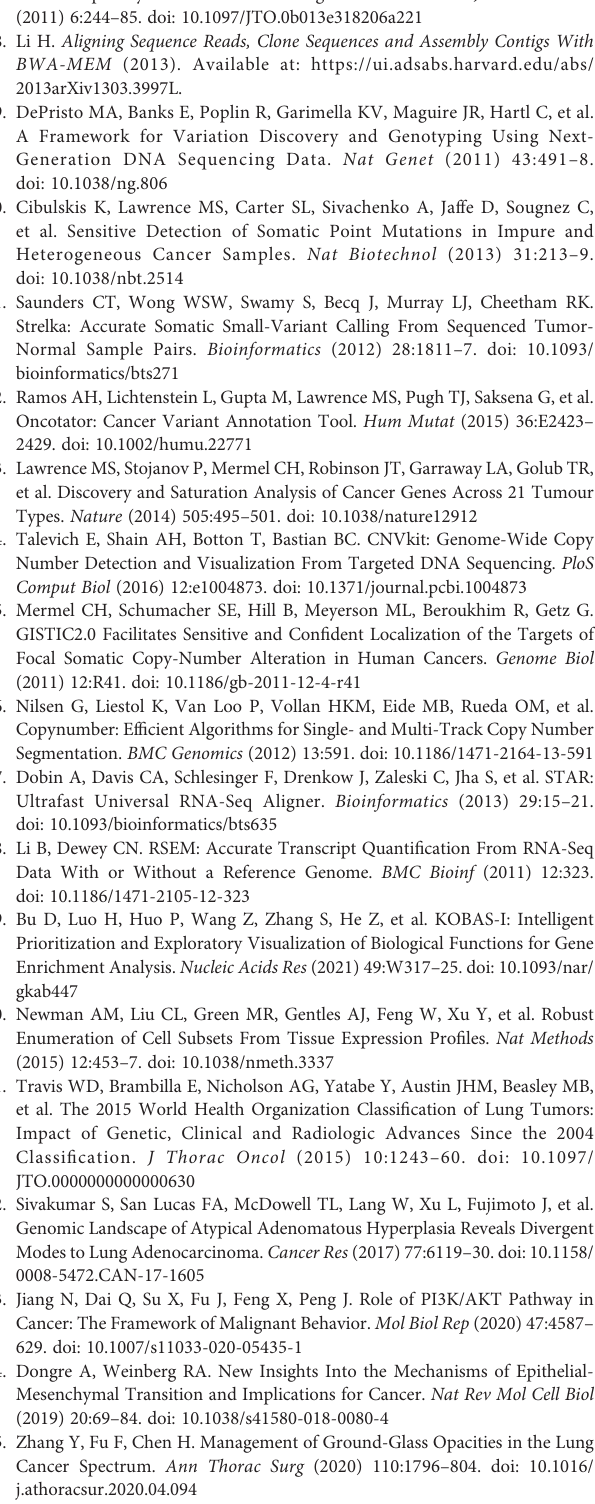
Supplementary Figure 2 | Comparison of tumor mutation burden (TMB) for different radiological groups.